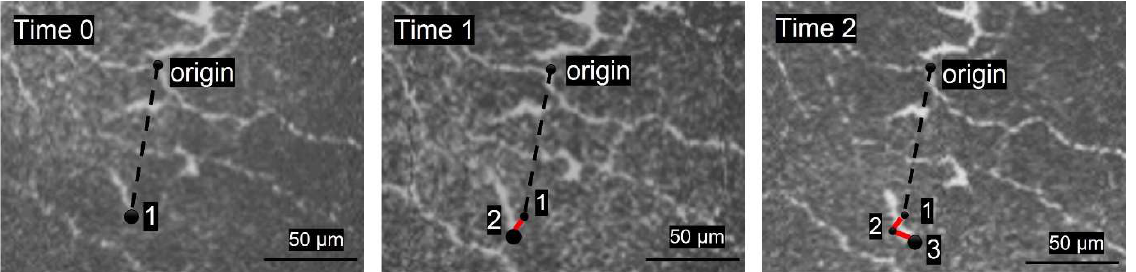
Figure 1. Schematic single-cell movement analysis. A nerve junction is utilized as the origin in the selected images. Time 0 shows the most distal aspect of the chosen DC (from the origin) marked to measure cell’s trajectory path (µm/min) between the selected images. Time 1 represents the cell distance travelled (red line) between points 1 to 2 (travelled length). Time 2 display the total cell trajectory path (the sum of the length between point 1, 2 and 3). The cell displacement is calculated from the distance between points 1 to 3.